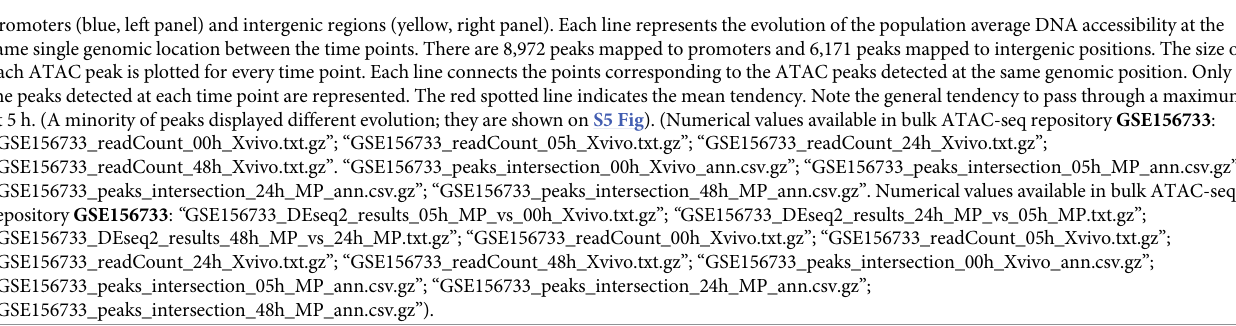
promoters (blue, left panel) and intergenic regions (yellow, right panel). Each line represents the evolution of the population average DNA accessibility at the same single genomic location between the time points. There are 8,972 peaks mapped to promoters and 6,171 peaks mapped to intergenic positions. The size